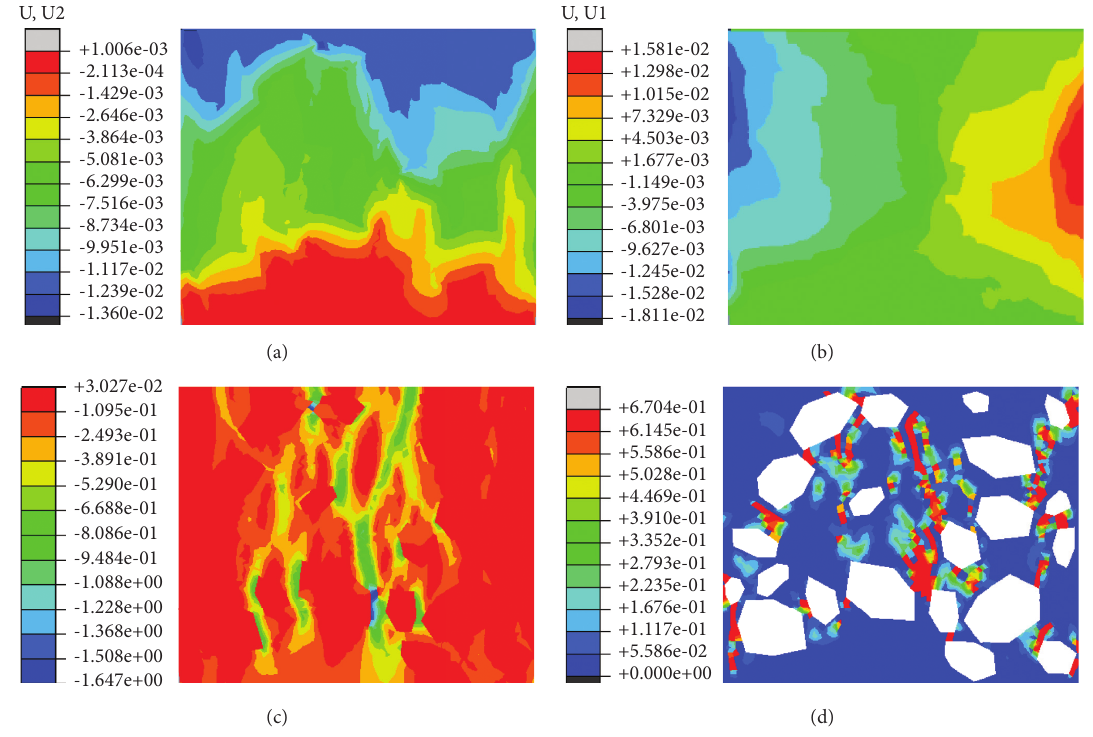
Figure 14: Model 1 simulation results: (a) displacement diagram in U2 direction, (b) displacement diagram in U1 direction, (c) axial stress diagram, and (d) damage diagram.